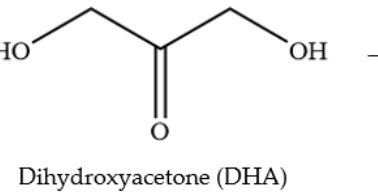
Figure 1. Formation of MGO from DHA.